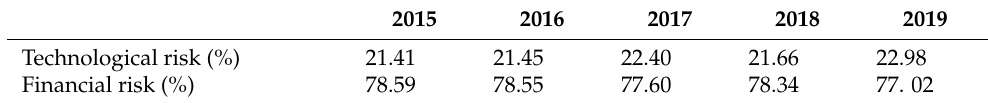
Table 4. The annual changes in the importance ratios of technical risk and financial risk.